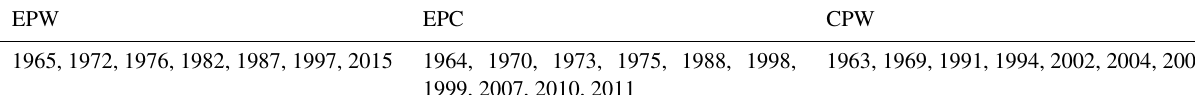
Table 1. Years dominated by CPW, EPC and EPW regimes during 1960–2015. EPW